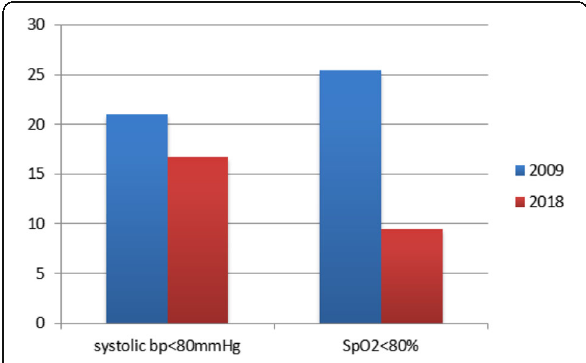
Fig. 1 (abstract 000295). See text for description